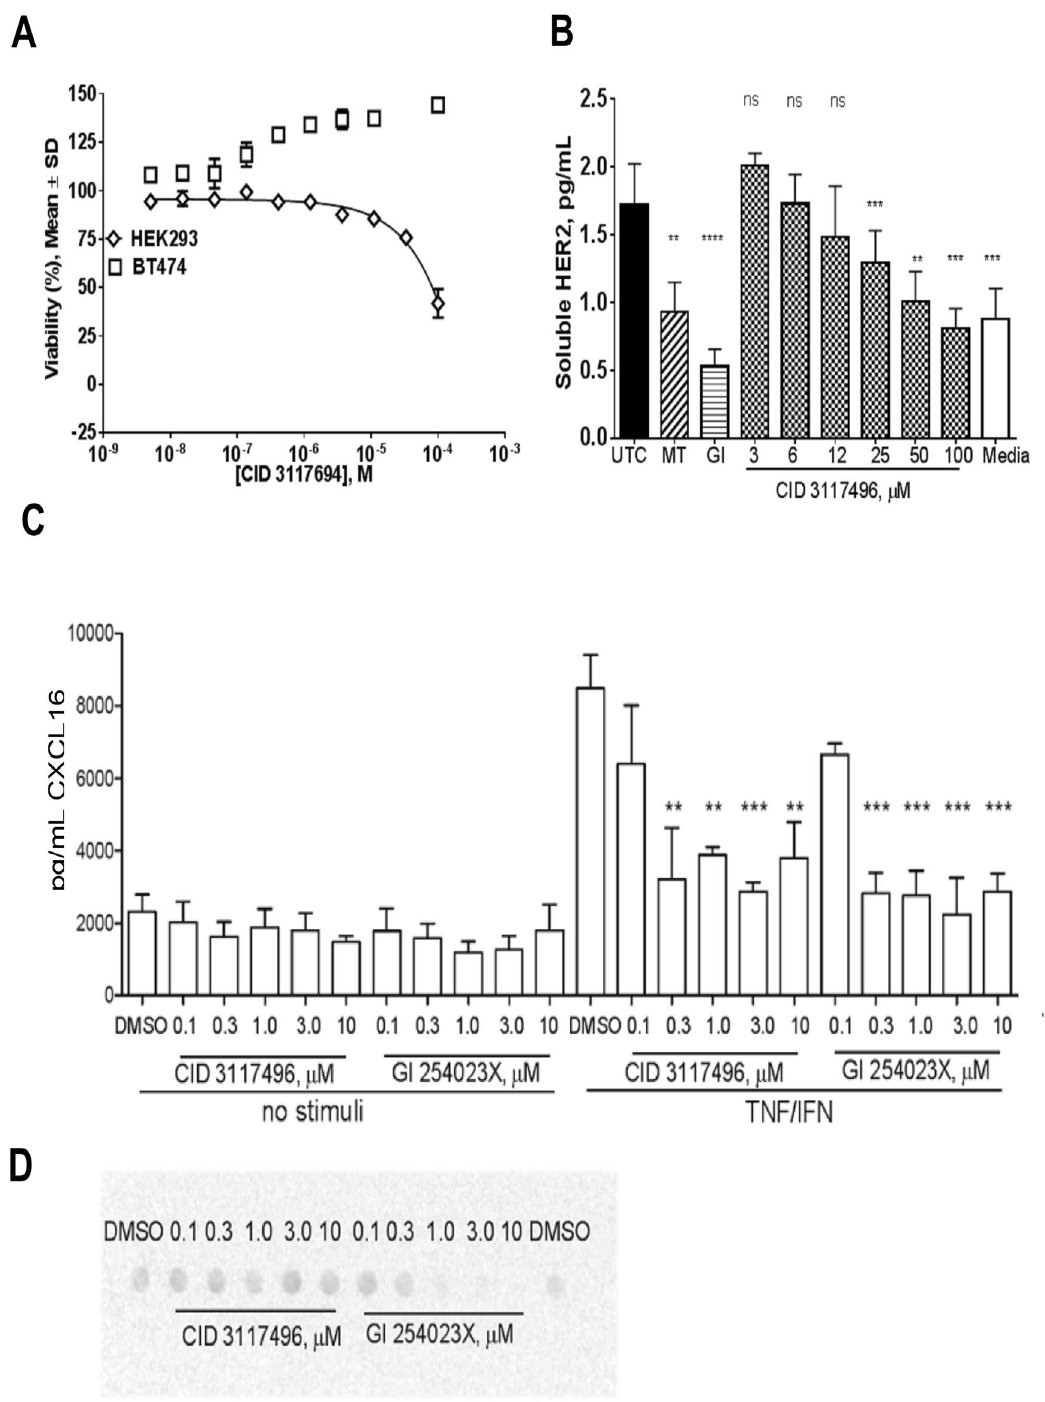
Figure 5. Inhibition of shedding of HER2, CXCL16 and syndecan by CID 3117694. ( A ) Effect of CID 3117694 on viability of BT474 breast cancer cells and HEK293 cells. Please note that only 100 µ M of CID 3117694 has moderate effect on HEK293 cell viability. ( B ) Inhibition of HER2 shedding in BT474 cells by CID 3117694. One-way analysis of variance (ANOVA) was used followed by Dunnett post hoc test. The data shown are the mean ± SEM, n = 3 from 3 independent experiments. ***** p value < 0.0001, *** p value < 0.001, ** p value < 0.01, * p value < 0.05; GI–control inhibitor of ADAM10 and MMPs GI254023X; ( C ) Results of CXCL16 ELISA assay in A549 lung cancer cells. The data shown are the mean ± SEM, n = 3 from 3 independent experiments. One-way analysis of variance (ANOVA) was used followed by Dunnett post hoc test. ***** p value < 0.0001, *** p value < 0.001, ** p value < 0.01, * p value < 0.05; all compared to DMSO TI. ( D ) Results of syndecan-4 dot blot assay (blot representative of three independent experiments